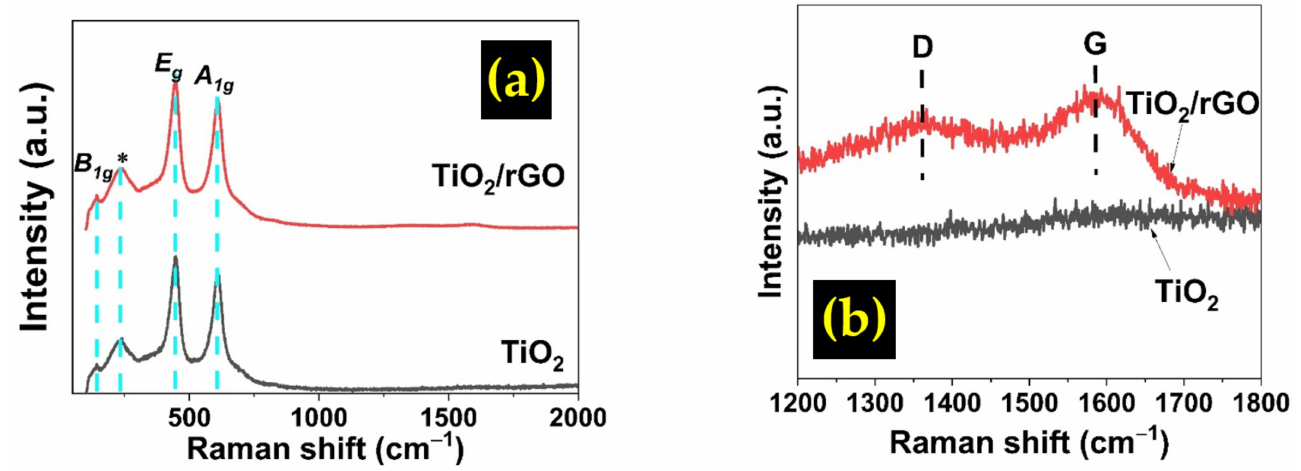
Figure 6. Raman spectra of TiO 2 and TiO 2 /rGO samples at the Raman shift range of: ( a ) 0–2000 (cm − 1 ) and ( b ) 1200–1800 (cm − 1 ).